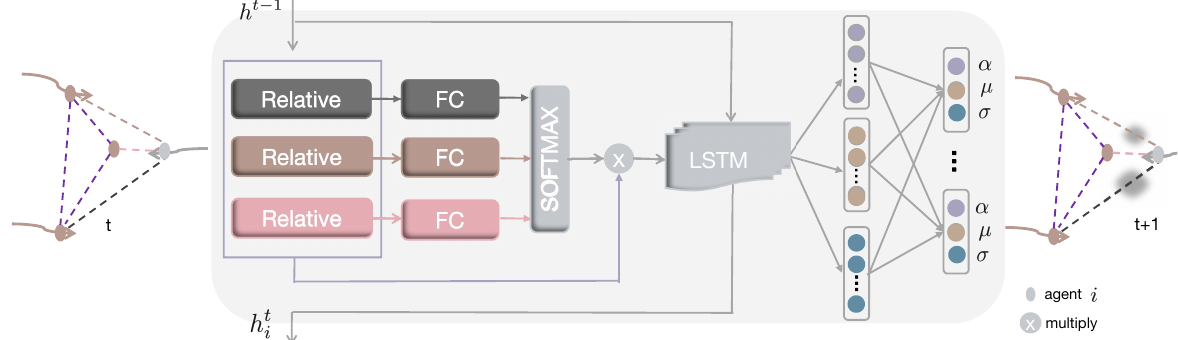
Figure 1. Overview of our method. We set an agent and illustrate the model. We use a separate LSTM for each person in a scene. The latent features from LSTMs are differencing to connect two interacting people, specially to construct spatial edges. The spatial edges are pooled to generate social features through an attention mechanism. Then the social features are fed into LSTM stacked with an Mixture Density Network (MDN) to forecast the distribution of future